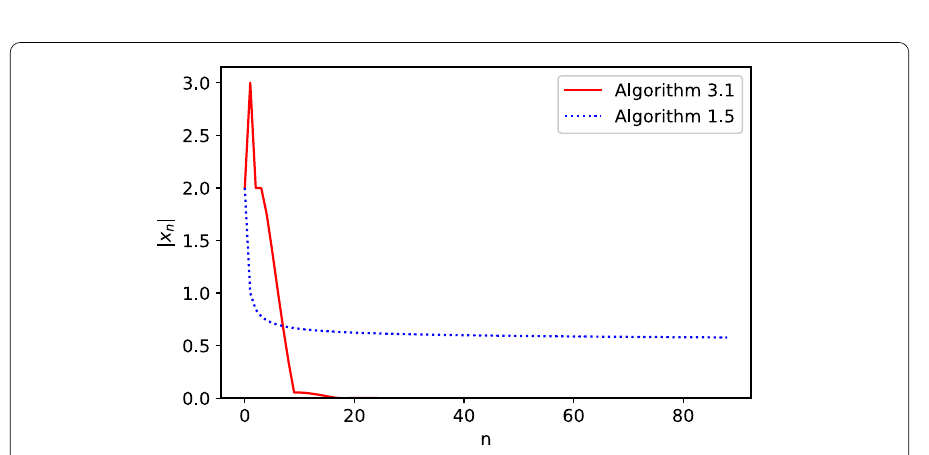
Figure 2 Graph of the first 85 iterates of Algorithms (1.5) and (3.1) choosing x 0 = –2, x 1 = 3